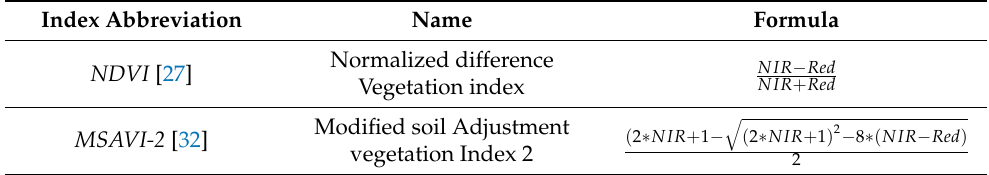
Table 2. Vegetation indices analyzed in this